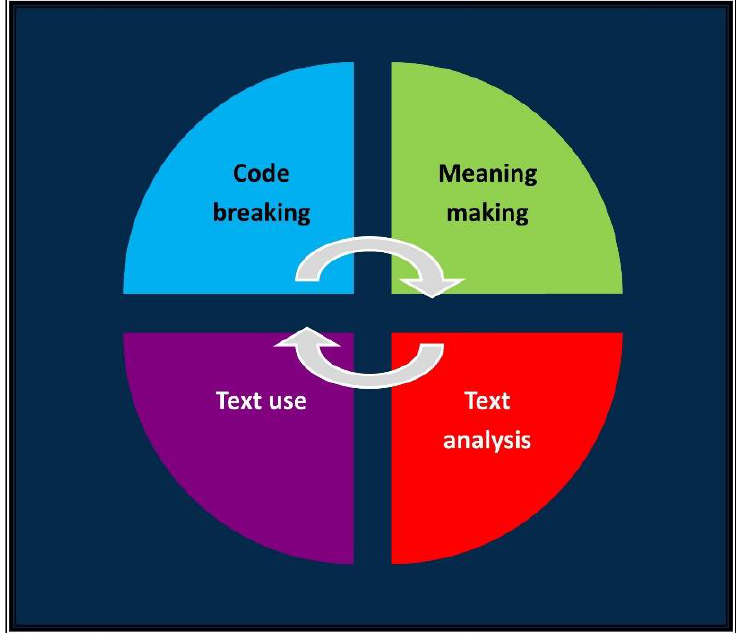
The 4RM for literacy [Adapted from Serafini,